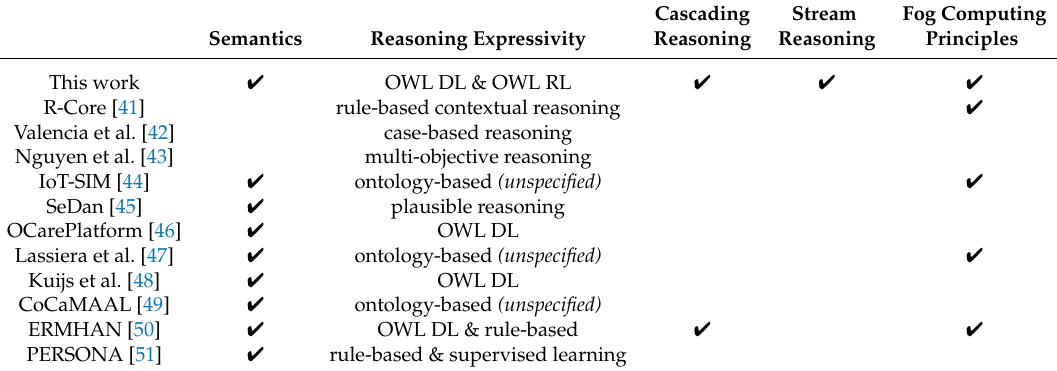
Table 2. Overview of the properties of the most prevalent state-of-the-art Ambient Assisted Living (AAL) frameworks and solutions, compared to the solution presented in this work. Cascading Stream Fog Computing Semantics Reasoning Expressivity Reasoning Reasoning